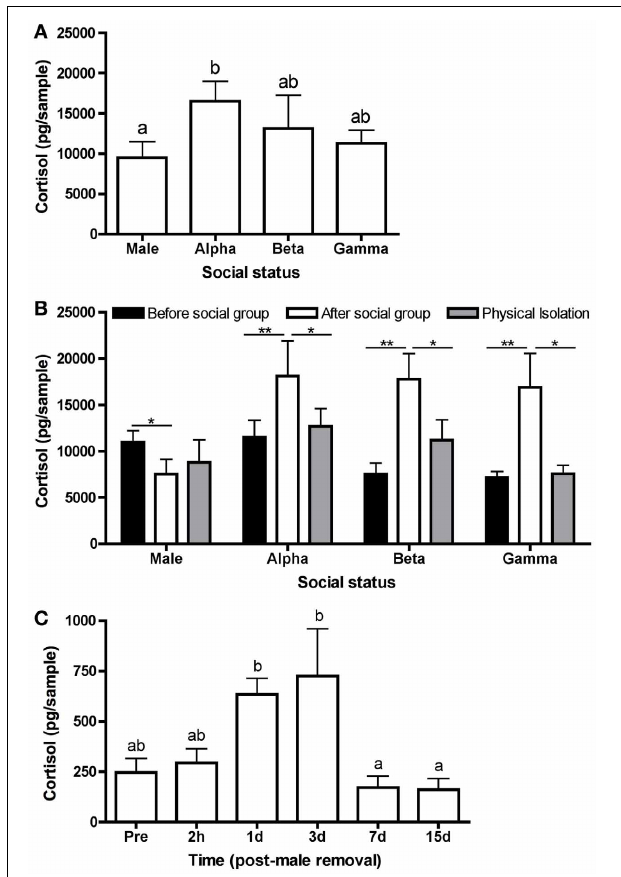
FIGURE 2 | Variation in water-borne cortisol levels. (A) Mean ( ± s.e.m.) cortisol levels in each status class from stable social groups. Cortisol levels differed significantly among males, alpha females, beta females, and gamma females after 21 days in a stable social group ( n = 39) (one-way ANOVA following a natural log transformation: F ( 3 , 149 ) = 3 . 64, p = 0 . 014). (B) Mean water-borne cortisol in males, alpha females, beta females, and gamma females prior to being placed in a social group (“before”) ( n = 15), after 21 days in a social group (“after”) ( n = 15), and following at least 1